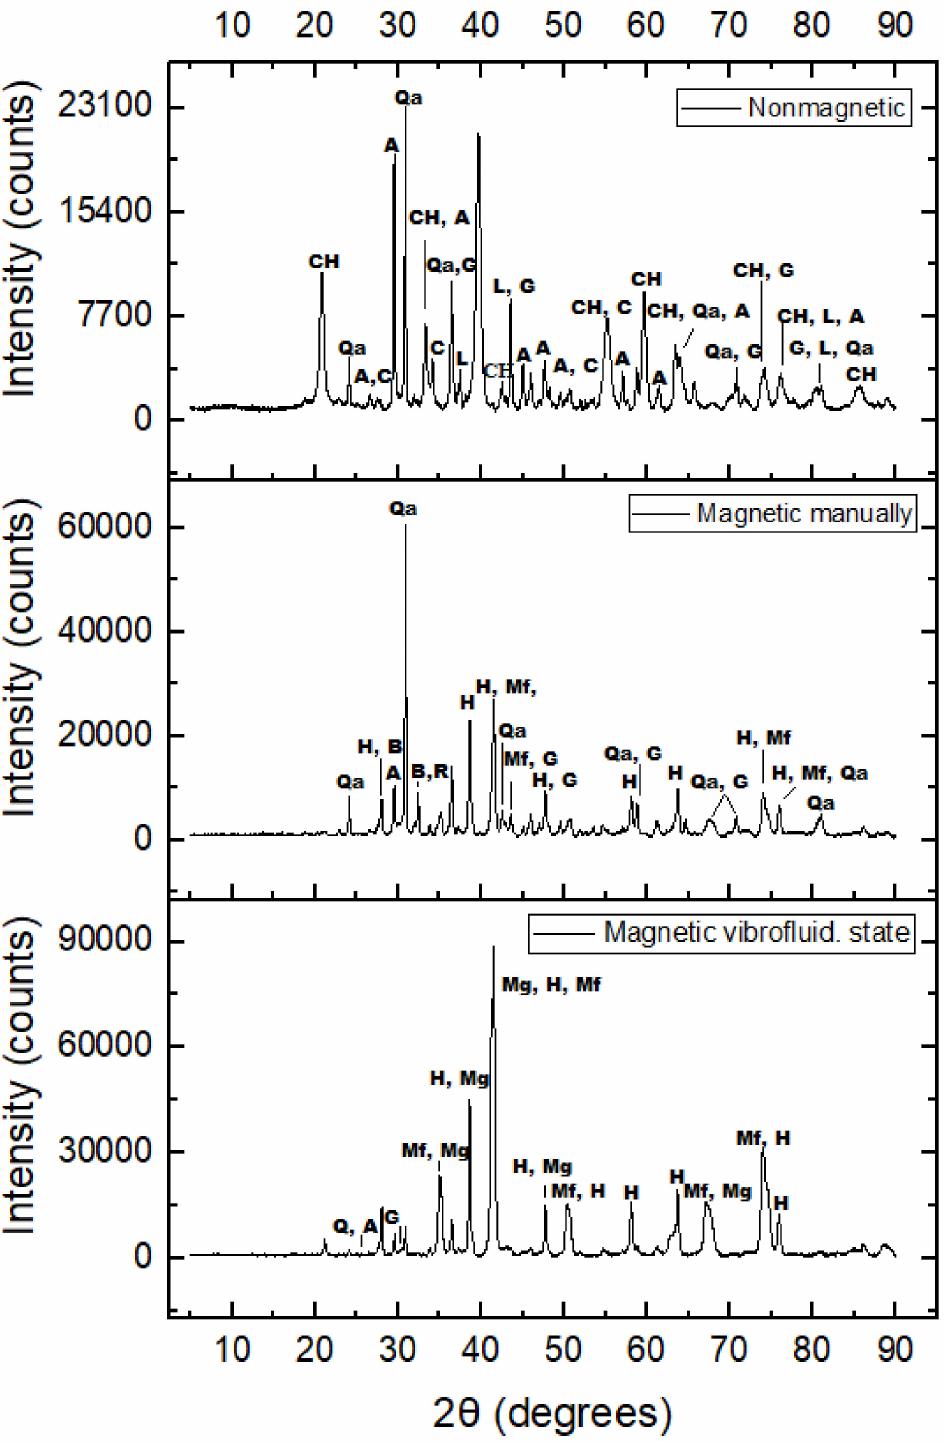
Figure 2. XRD patterns of the magnetic vibrofluid state, magnetic manual, and nonmagnetic frac- tions of the finest < 0.2 mm (A = Anhydride, B = Bilinite, C = Calcite, CH = Calcium Hydroxide, G = Gehlenite, H = Hematite, L = Lime, Mg = Maghemite, Mf = Magnesioferrite, Q = Quartz, Qa = Quartz alpha, R =